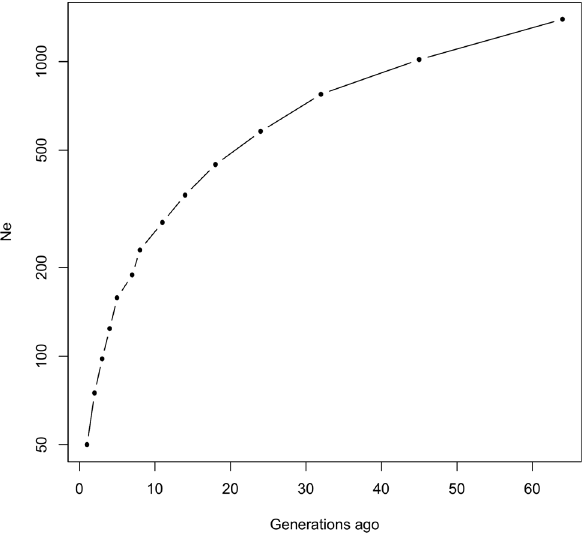
Figure 3 - Average-estimated effective population size in the Tunisian cattlepopulation,plottedagainstaveragegenerationsinthepast,truncated at 64 generations. Estimated effective population size was plotted on a log